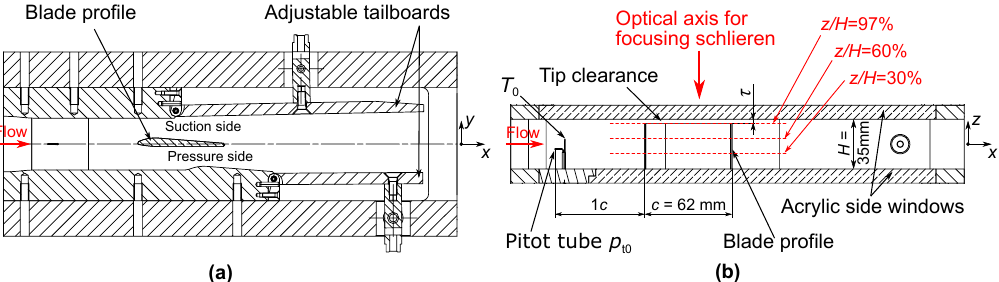
Figure 6. Sketch of the test section geometry for the idealized blade tip-clearance model: ( a ) view of channel geometry in x - y -plane and ( b ) illustration of tip clearance and locations of focusing planes in x - z